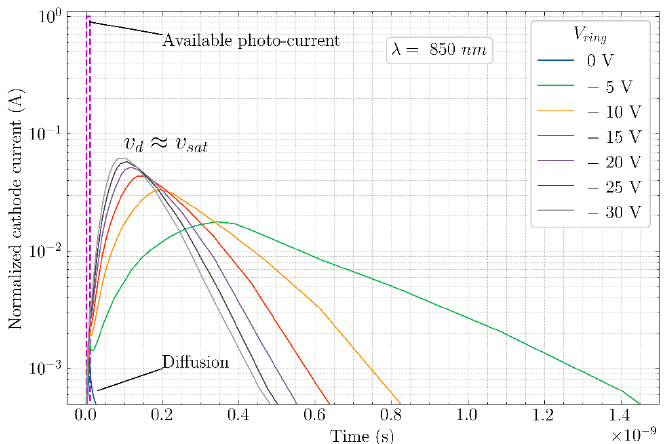
Figure 4. Simulated timing response of the device when illuminated with a sharp light pulse (10 ps) of 850 nm for a few different ring